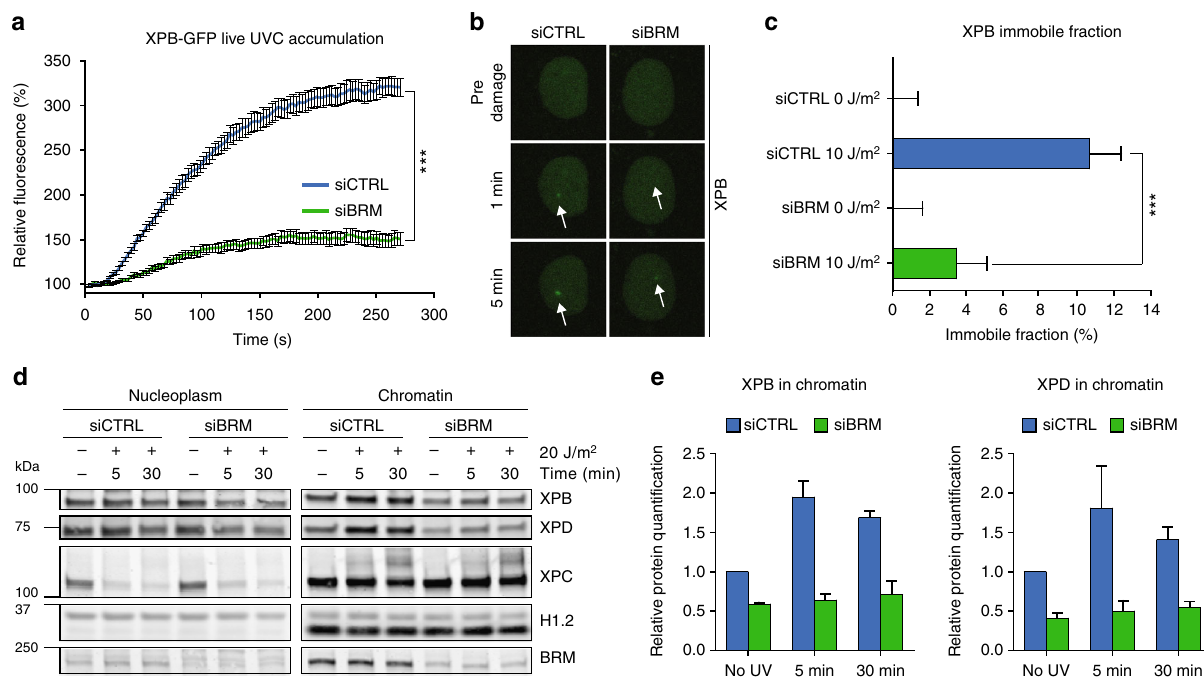
Fig. 2 BRM is required for the recruitment of TFIIH to chromatin. a Real-time imaging of XPB-GFP accumulation at 266 nm UV-C laser-induced LUD in XPCS2BA cells treated with control and BRM siRNA (siCTRL and siBRM, respectively; Supplementary Fig. 1f). Pre-damage fl uorescence intensity (nuclear background) was set to 100% ( t = 0). Mean & S.E.M. of three independent experiments each with more than ten cells per condition. P < 0.001, compared to siCTRL. b Representative images of real-time recruitment of XPB-GFP, which resides exclusively in the nucleus, to laser generated LUD. Arrows indicate LUD regions. c Quanti fi cation of XPB-GFP immobile fraction in XPCS2BA fi broblasts. The mobility of XPB-GFP was determined by fl uorescence recovery after photobleaching (FRAP) in mock and UV-C irradiated (10 J/m 2 ) cells treated with non-targeting control (CTRL) or BRM siRNAs, as depicted in Supplementary Fig. 1h. The UV-induced immobile fraction (mean & S.E.M. from three independent experiments, with at least ten cells measured per condition each time) was determined as described in Supplementary Fig. 1h. *** P < 0.001 relative to UV-irradiated siCTRL. d Immunostaining of soluble (nucleoplasm) and chromatin-bound XPB, XPD, XPC, BRM, and H1.2 (as loading control) in U2OS cells treated with non-targeting control (CTRL) or BRM siRNAs. Cells were collected for protein fractionation at different time points after UV-C irradiation (20 J/m 2 ). e Relative quanti fi cation of chromatin-bound XPB and XPD, normalized to non-irradiated siCTRL, set to 1.0. Mean & S.E.M. of two independent experiments. Full-size immunoblot scans are provided